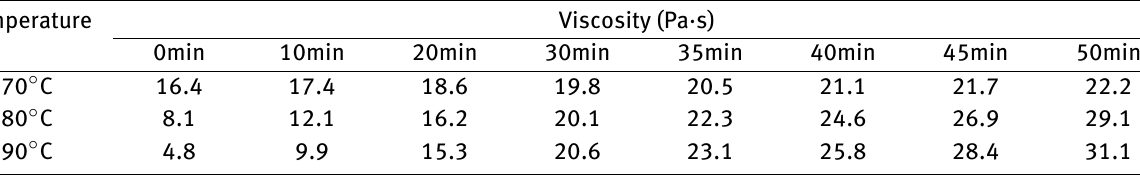
Table 1: Viscosity-time characteristics of neat phenolic resin